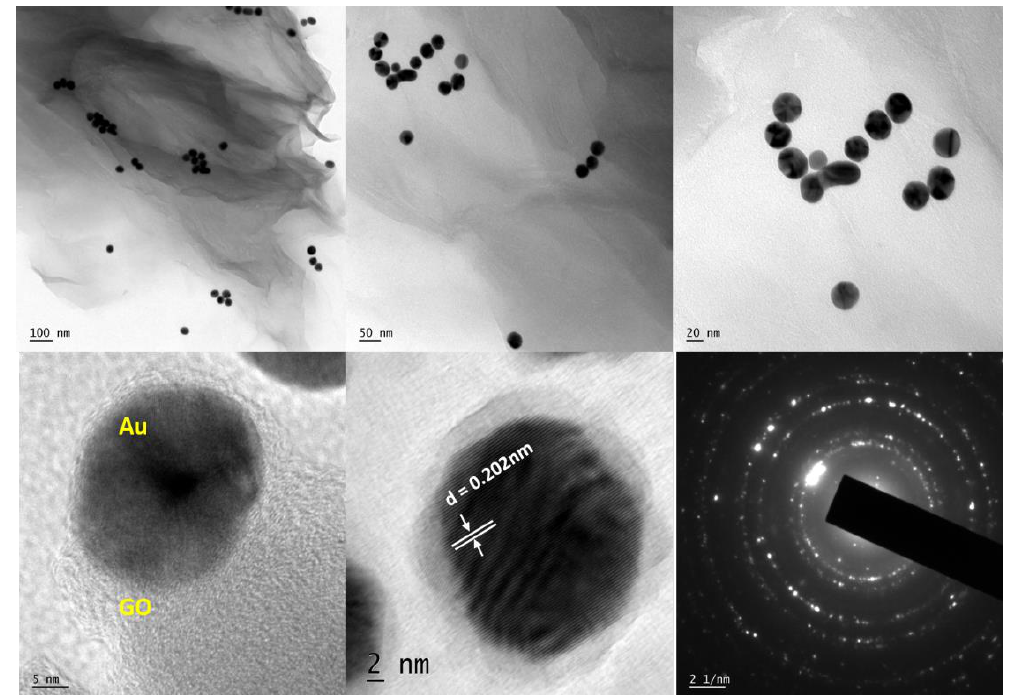
Figure 4. TEM and HRTEM images of the Au-GO nano-hybrid.